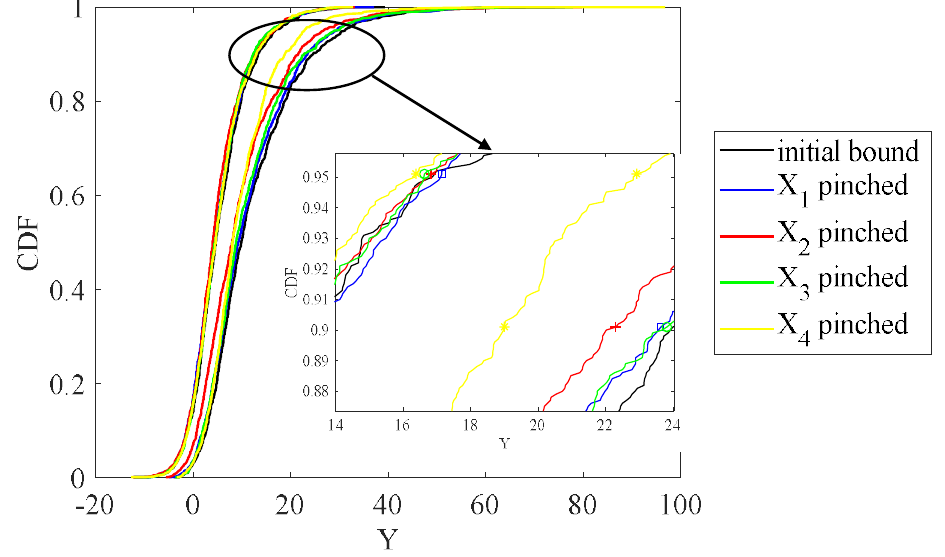
Figure 10. P−boxes for the system analytical function with diverse correlated inputs pinched. Table 2. The ranking order of the epistemic model parameters based on their respective sensitivity index.